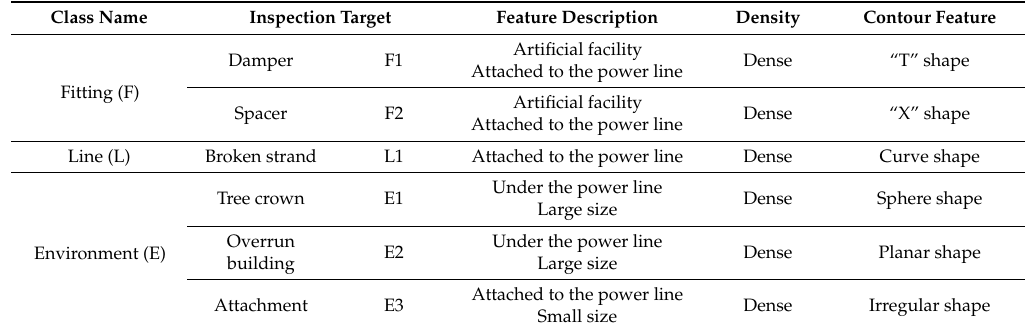
Table 2. Characteristic rules of inspection targets.